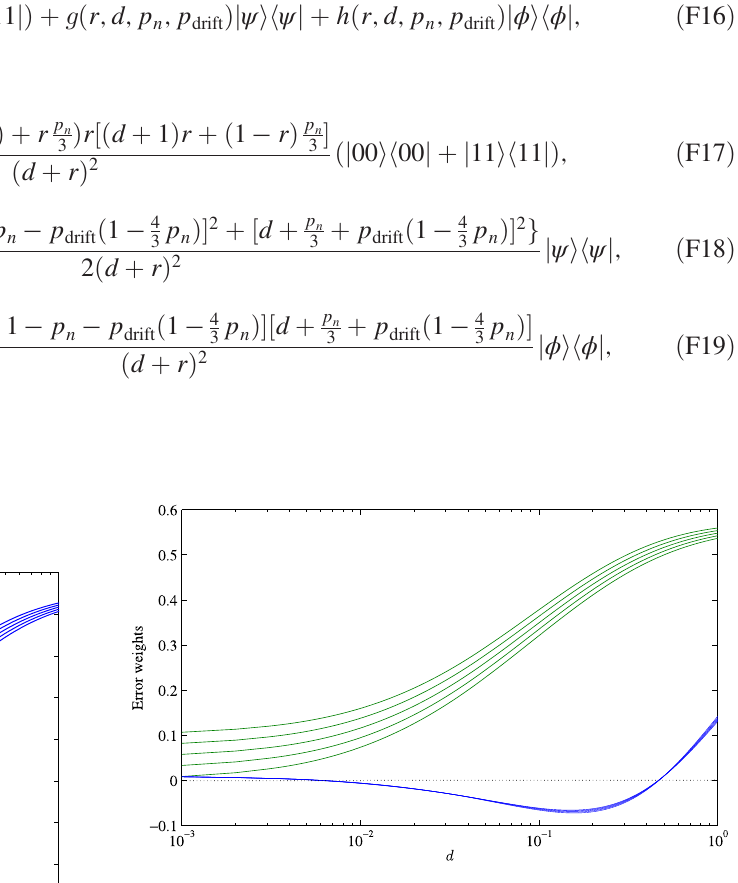
FIG. 14. Influence of dark counts on effective preparation and 0 . 01 . The five upper drift error probabilities for r ¼ 1 and p 4 drift ¼ lines (green) represent the effective preparation error weight ( p 0 ) n corresponding, from bottom to top, to preparation error proba- and 4 0 ; 0 . 025 ; 0 . 05 ; 0 . 075 ; 0 . 1 g . The lower lines (blue), bilities p n ¼ f indistinguishable at this scale, correspond to the effective drift error weight ( p ) for the same values of p . In the regions n drift d ≤ 0 . 007 and d ≥ 0 . 469 , both p 0 and p correspond to n drift valid probabilities, and hence, in these regimes dark counts 0 . are indistinguishable from other noise n ¼